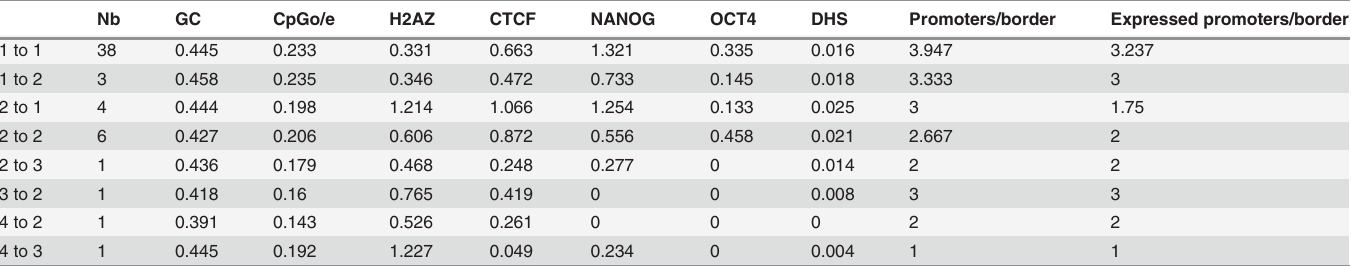
Table 4. Sequence, epigenetic and gene characteristics of conserved (n = 6) replication U-domain borders of H1hesc that switch from state ECi to Cj.